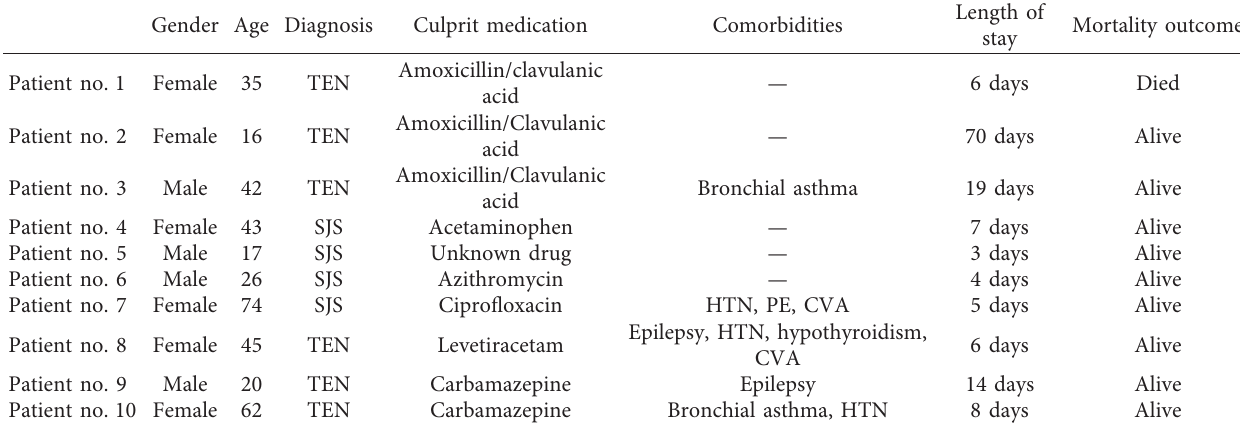
Table 1: The demographics, clinical characteristics, and outcome of study patients ( N �